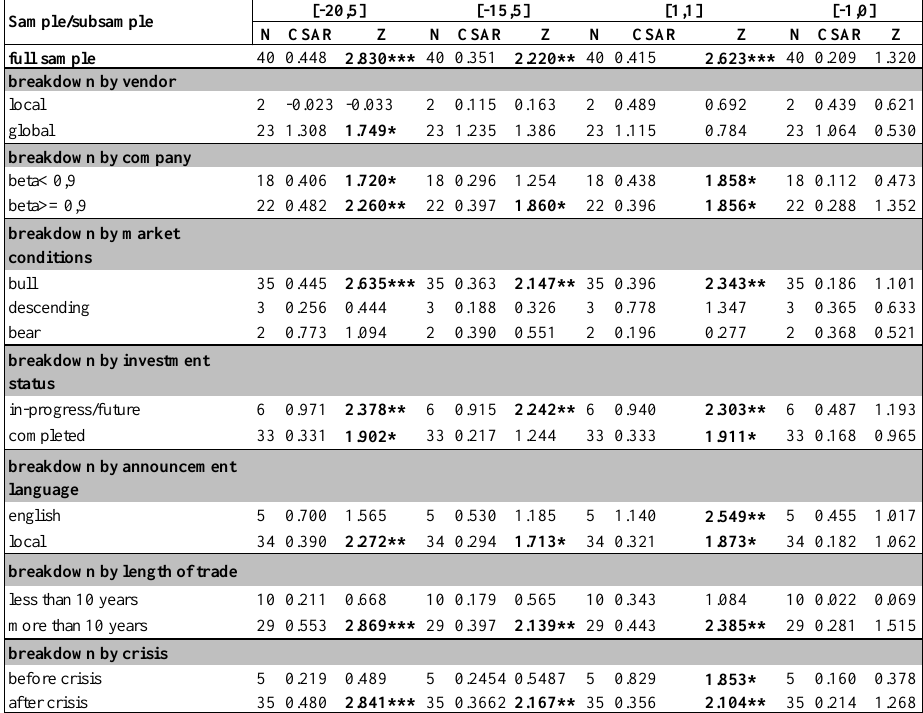
Table 1 – Summary of results from